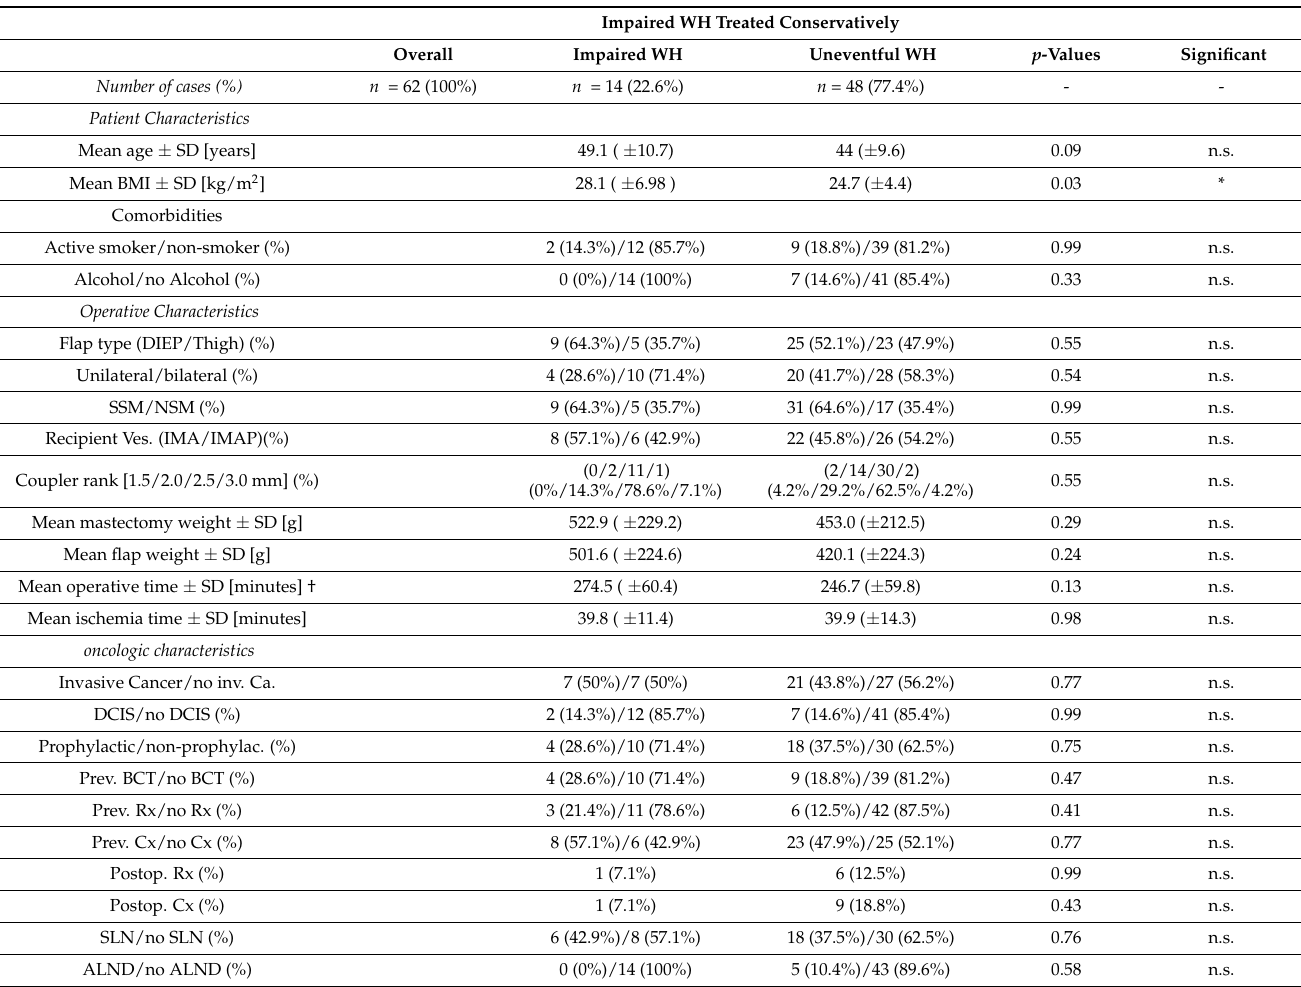
Table 5. Univariate analysis of risk factors between cases with impaired WH treated conservatively and cases without impaired